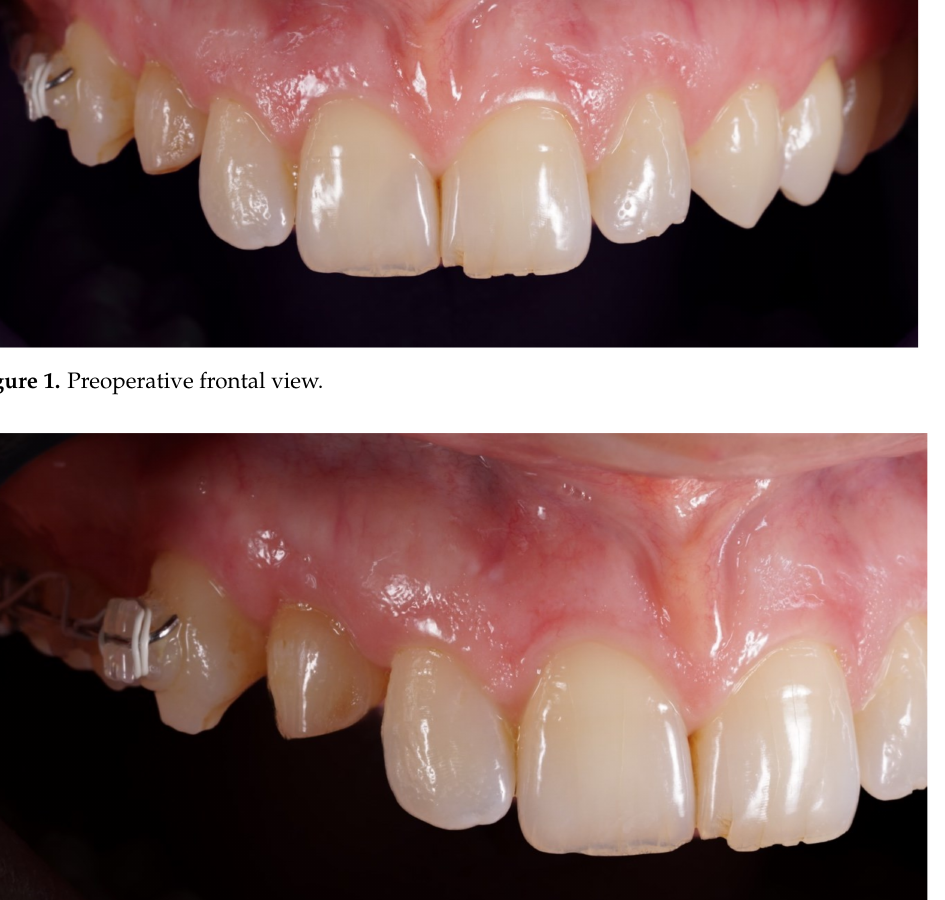
Figure 2. Lateral preoperative view.